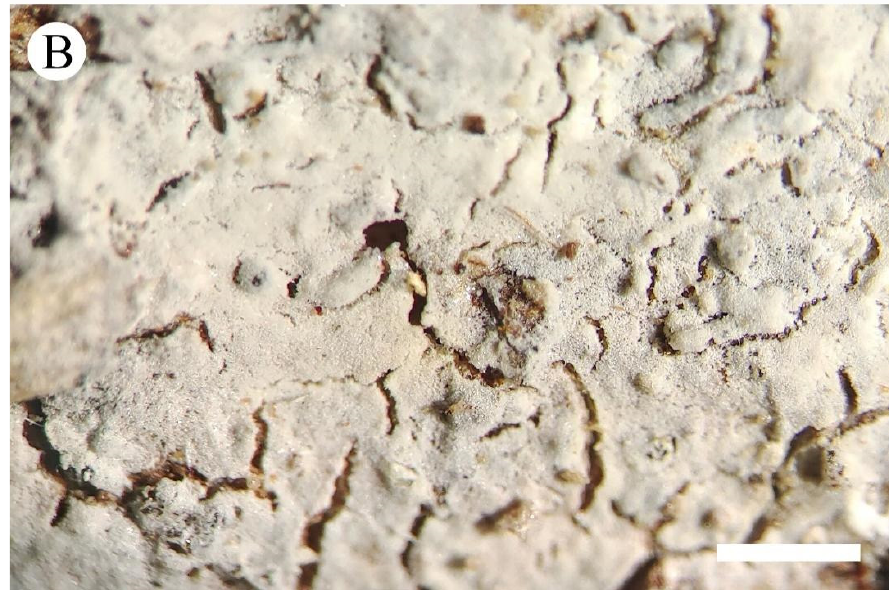
Figure 5. Basidiomata of Xylodon punctus (holotype): the front of the basidiomata ( A ), characteristic hymenophore ( B ). Bars: ( A ) = 1 cm and ( B ) = 1 mm.